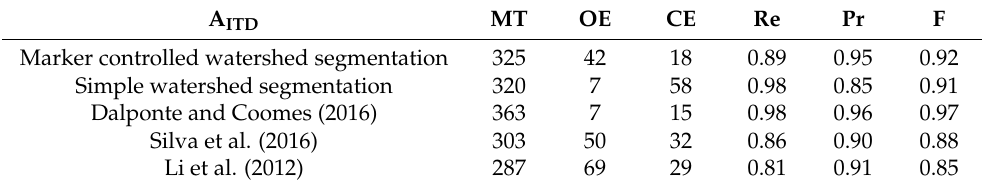
Table 1. Results of A ITD accuracy for 300 individual trees (MT: the number of matched trees, OE: the number of omission errors, CE: the number of commission errors, Re: recall, Pr: precision, F: F -score).